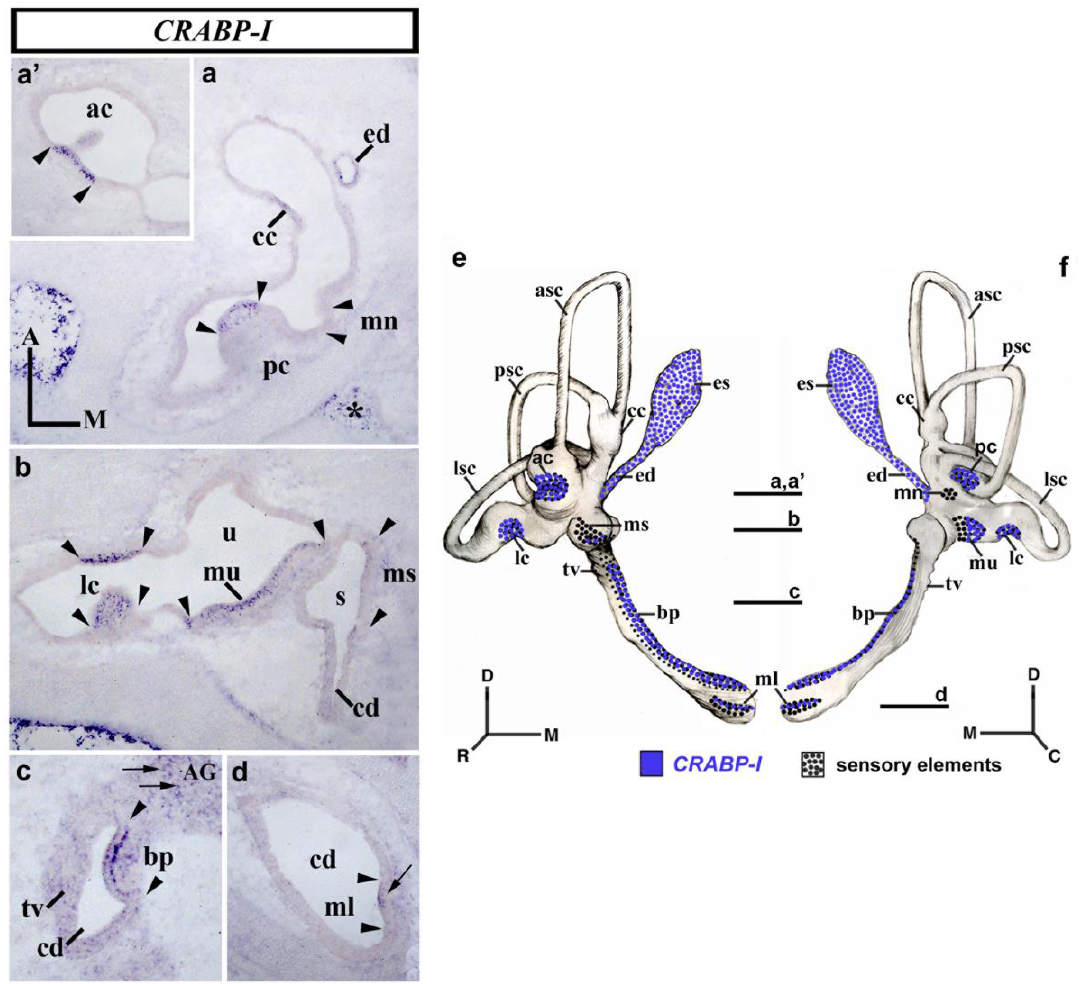
Figure 4. CRABP-I expression patterns at stage HH32. Horizontal sections through the inner ear anlagen treated with the CRABP-I probes. The sensory patches are indicated between arrowheads in all pictures. At this stage, all labeled cells identified in the otic epithelium exhibited high levels of CRABP-I expression. All the cristae displayed CRABP-I -expressing cells (pc, ( a ); ac, ( a ′ ); lc, ( b )). The macula utriculi and the basilar papilla also showed CRABP-I -stained cells (mu in ( b ); pb in ( c )). The macula sacculi and macula lagena showed a few CRABP-I -expressing cells (ms in ( b ); ml in ( d )), although much less evident in the former. The macula neglecta was devoid of CRABP-I expression (mn, ( a )). The endolymphatic duct and part of the crus commune exhibited CRABP-I expression (ed and cc; ( a )). The AG and VG displayed scattered CRABP-I -positive cells (AG, small arrows in ( c ); VG, not shown). The mesenchyme far from the otic epithelium showed CRABP-I expression (asterisks in ( a )). ( e , f ), 3D CRABP-I expression pattern diagrams, showing anterior ( e ) and posterior ( f ) views of the inner ear at stage HH34. The horizontal sections were indicated. Dotted areas represent the sensory domains. For the abbreviations, see the list. Orientation: A, anterior; D, dorsal; M, medial; P, posterior.